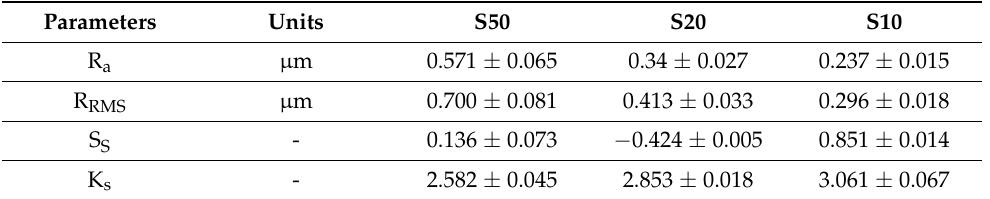
Table 1. Surface height parameters R a , R RMS , S S , and Ks. The average results were expressed as mean values and standard deviation.